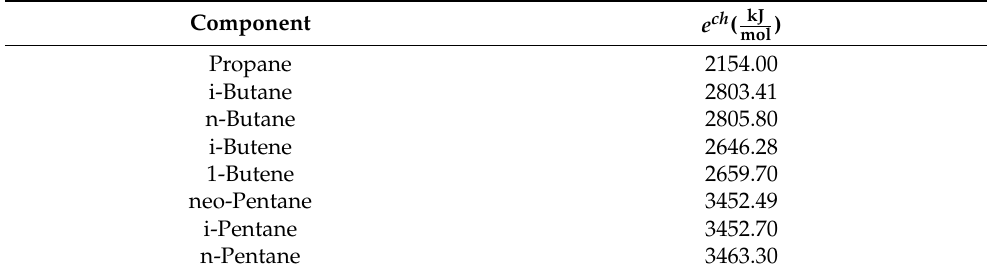
) mol 2659.70 3452.70